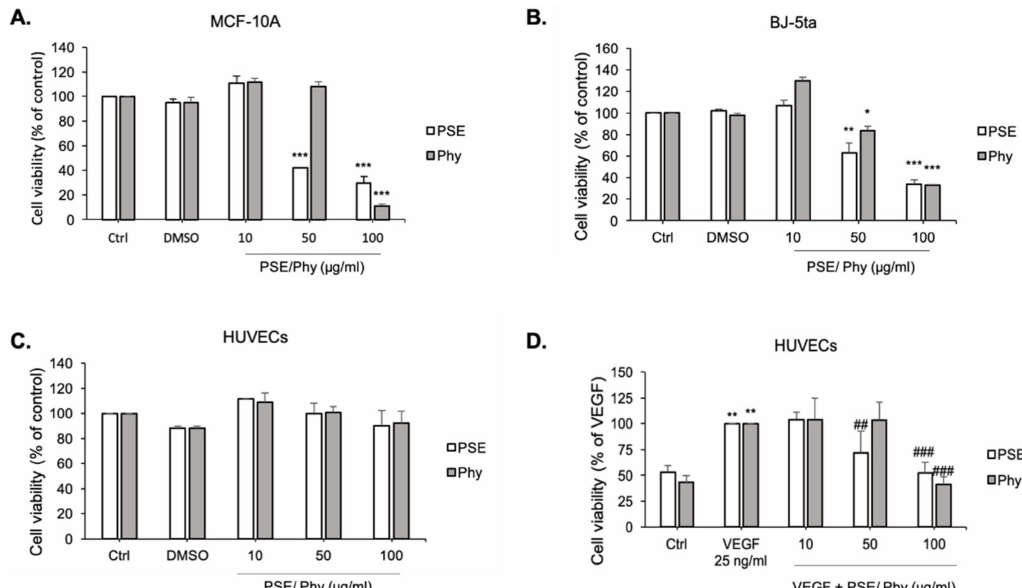
Figure 3. Effect of Pseudevernia furfuracea extract (PSE) and Physodic acid (Phy) on MCF-10A, BJ-5ta and HUVEC cells’ viability. MCF-10A ( A ) and BJ-5ta ( B ) cells were treated with various concentrations of PSE and Phy (10–100 µ g/mol) for 72 h. HUVECs were treated with the same range of concentrations of tested compounds in the absence ( C ) or presence ( D ) of VEGF (Vascular endothelial growth factor) (25 ng/mL) for 48 h. Values represent the mean ± standard deviation. (* p < 0.05, ** p < 0.01, *** p < 0.001 compared to control; ## p < 0.01, ### p < 0.001 compared to VEGF based on Student’s t-test). Table 3. The inhibitory concentrations IC 10 and IC 50 values of Pseudevernia furfuracea extract (